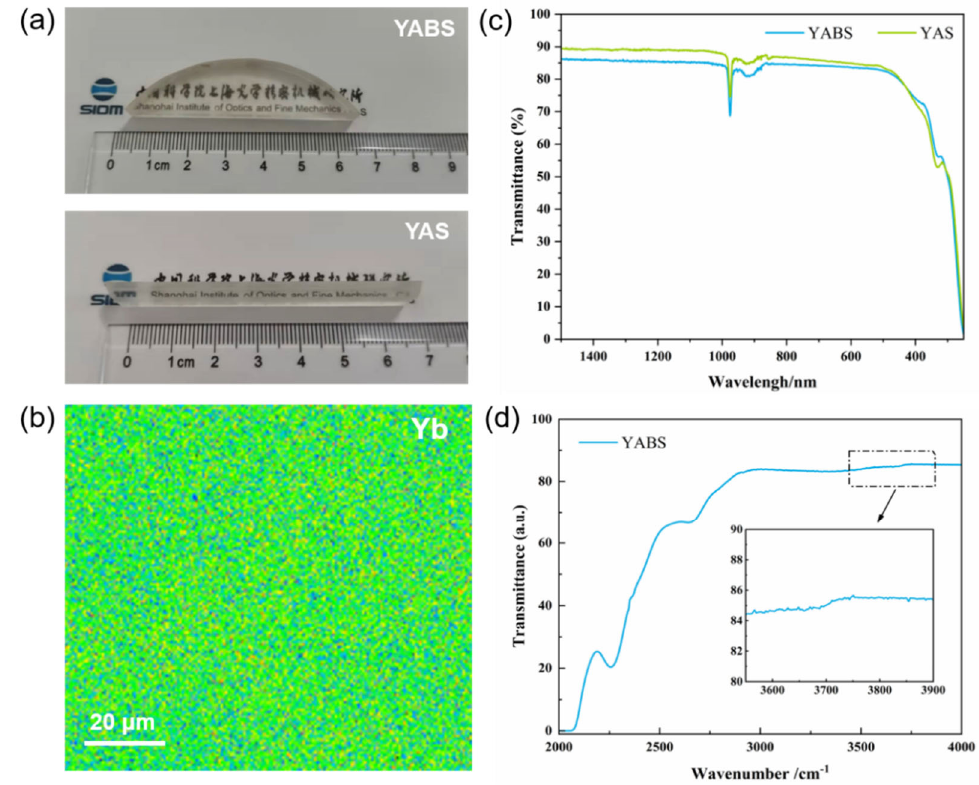
Figure 2. ( a ) YABS and YAS bulk glass after proper processing; ( b ) EPMA surface scan of Yb ele ‐ ments in YABS glasses with a scan window size of about: 200 × 200 μ m; ( c ) transmittance curves of YABS and YAS glass; ( d ) infrared transmission spectra of YABS glass, inset shows a local magnifi ‐ cation of the absorption band near 3650 cm ‐ 1